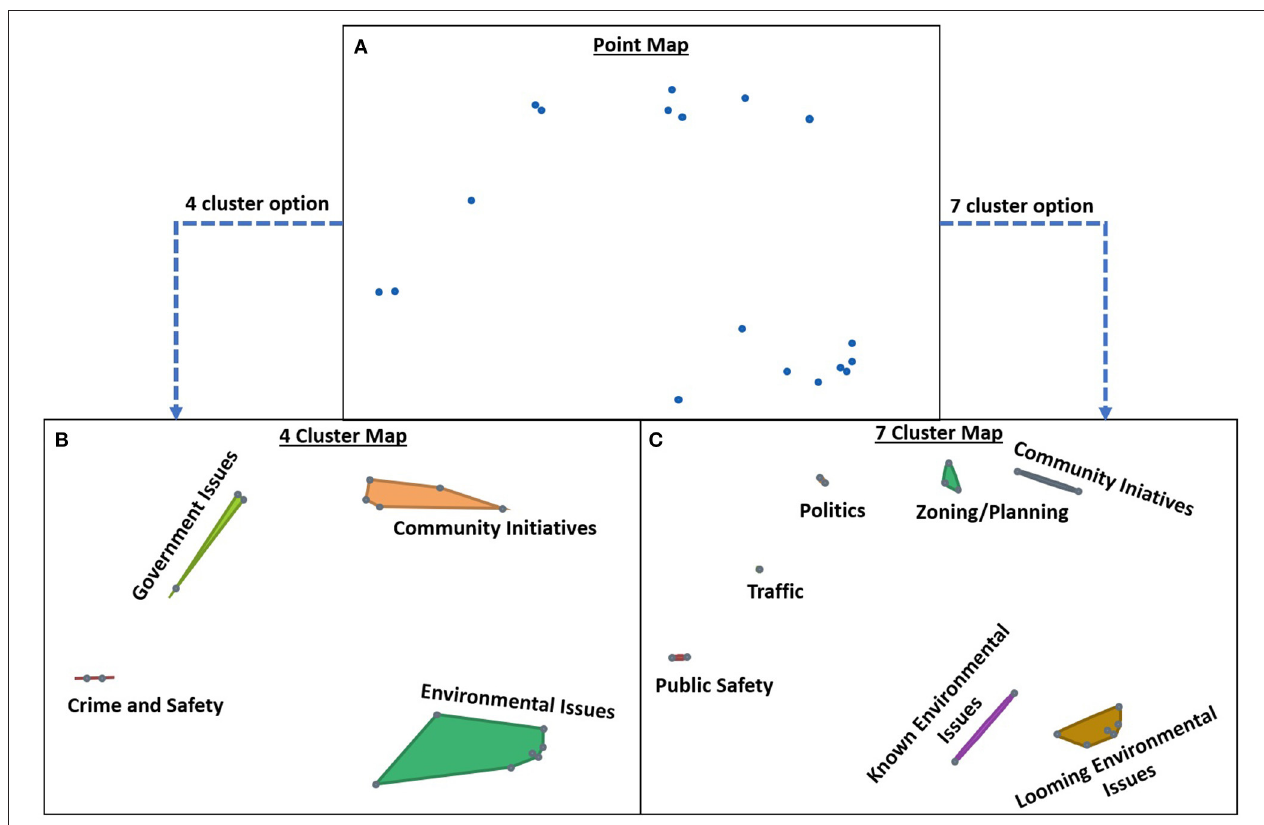
FIGURE 1 | Point Map and Cluster Maps. The Point Map (A) represents each statement generated by participants, with statements that were frequently sorted together placed closer together on the map. Using hierarchical cluster analysis, the points are grouped into different arrangements of clusters and possible cluster labels. Two cluster arrangements are depicted here (B,C) , with different labels representing pile names provided by participants during the sorting phase. See Figure 2D for the cluster rating map, which depicts the average rating for each cluster in the final concept map chosen by Community